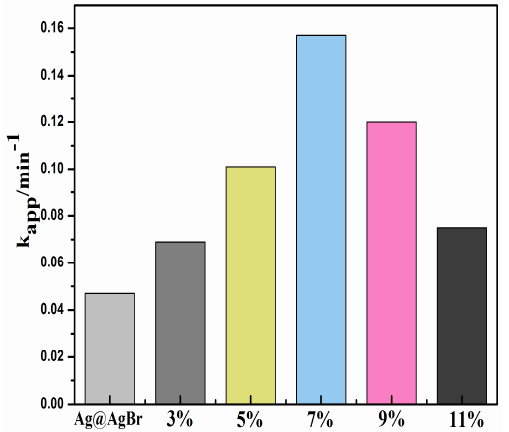
Figure 8. The kinetic rate constants of Ag@AgBr and Ag@AgBr/Bi 2 O 2 CO 3 composite with different Ag@AgBr content for the photocatalytic degradation of MB under visible light irradiation.